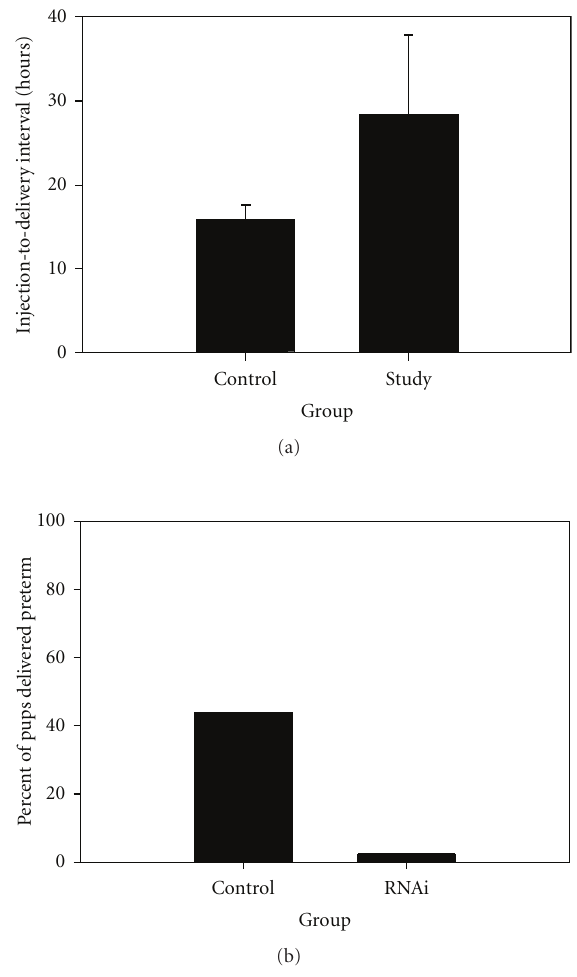
Figure 2: E ff ect of ET-1 blockade on preterm delivery in the mouse model. (a) Incidence of preterm delivery in the mouse model in the absence, presence of high-dose, or presence of low-dose BQ-123 ( P < . 01 between control and high-dose groups, Fisher’s exact test). (b) E ff ect of SiRNA for ECE-1 in the animal model of infection- associated PTB ( P < . 001, Fisher’s exact